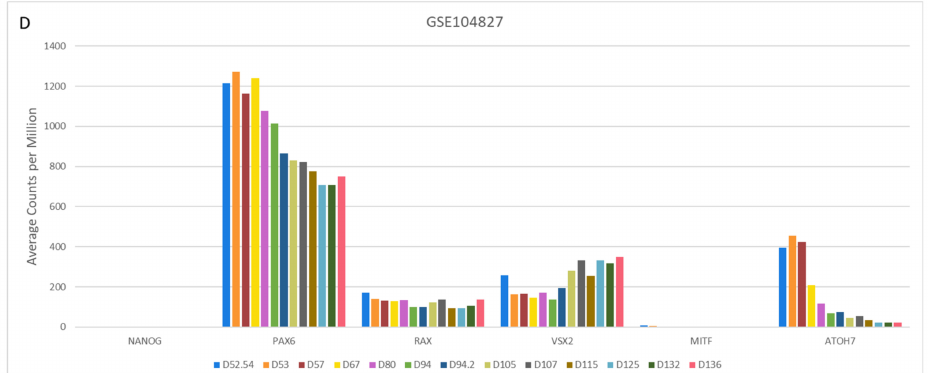
Figure 11. RNA-seq analysis of differing methods of in vitro retinal development, in addition to in vivo fetal retinal development. We compared the gene expression of our pilot experiment to RNA-seq analysis of different retinal organoid differentiations and fetal retina samples. ( A ) Our previously published protocol using H1 embryonic stem cells shared similar gene expression with our pilot experiment shown in this manuscript over the course of the first 34 days. ( B ) A different method of generating retinal organoids using the H1 embryonic stem cell line also showed expression of key retinal genes increasing over the first month, comparably to our pilot experiment and RNA-seq. ( C ) Retinal organoids generated from a different embryonic stem cell line (H9) showed variable expression levels of key genes when compared to A and B. Some genes, such as RAX , increased over time in line with other RNA-seqs; however, other genes, such as VSX2 , unexpectedly decreased over time. ( D ) RNA-seq of fetal retina presented surprising results. After being expressed by day 10, PAX6 and RAX both decreased until day 69, before significantly increasing along with VSX2 . This was not shown in RNA-seqs of retinal organoids, where PAX6 and RAX expression slowly increased throughout earlier time points, not